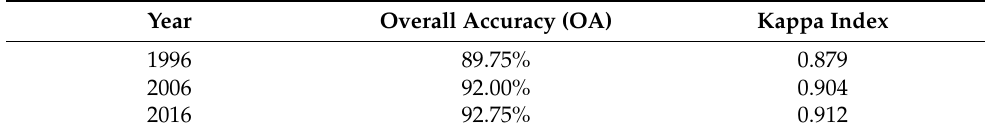
Figure 2. Methodological flowchart for quantifying urban growth in KMA. Table 1. Summary of accuracy assessment of the classified